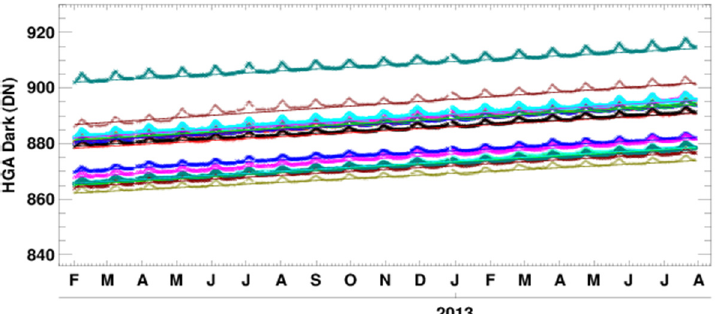
Figure 16. DNB BB daily mean dark signal DN for HGA, aggregation mode 1. The measured values for each detector are represented by symbols. The lines are fitted values using new moon data. The periodic increase in DN corresponded to the increase in lunar illumination. At full moon, the dark response is up to 5 dn (~ 8 ˆ 10 ´ 11 W ¨ cm ´ 2 ¨ sr ´ 1 ) higher than the new